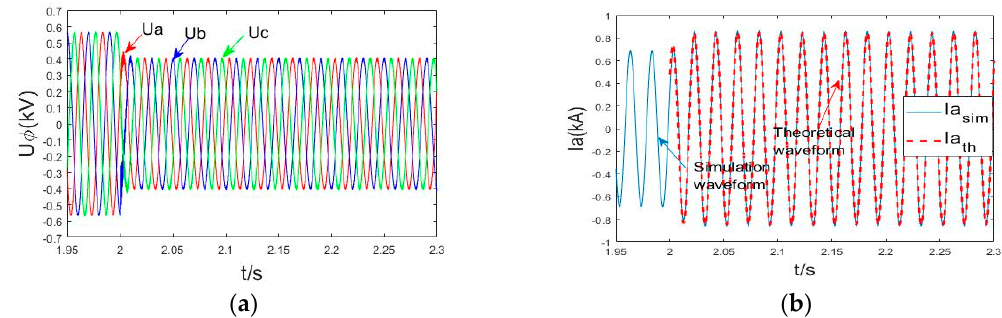
Figure 12. ( a ) Waveforms of three-phase voltage. ( b ) Waveforms of phase-A output current when unloading circuit